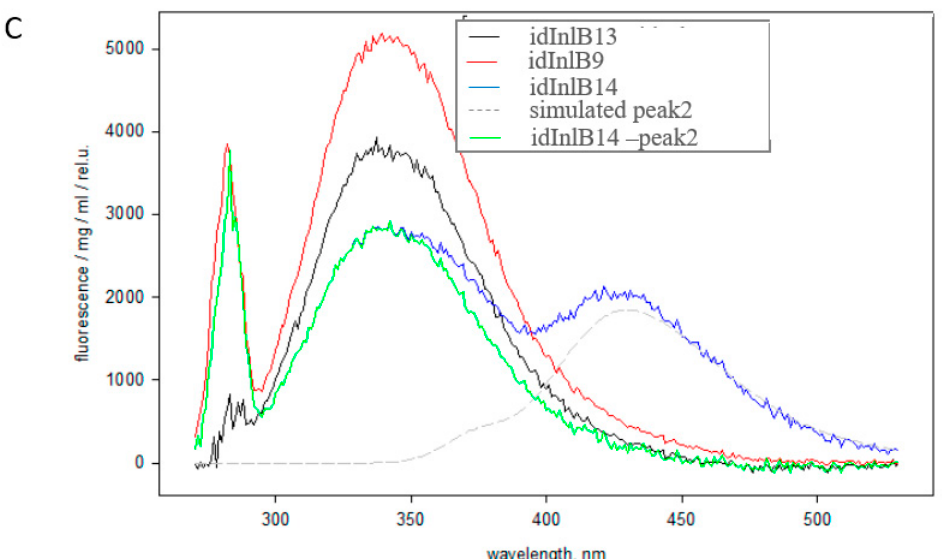
Figure 1. Physicochemical characteristics of idInlB isoforms: ( a ) Amino acid substitutions. The idInlB13 sequence was taken as a basis. Substitutions between lineages I and II idInlBs are shown in bold. LRR for l eucine r ich r epear; ( b ) size exclusion chromatography (SEC) of purified idInlBs; ( c ) fluorescence spectra of purified idInlBs. For idInlB14, original and retracted spectra are shown (see text for details).